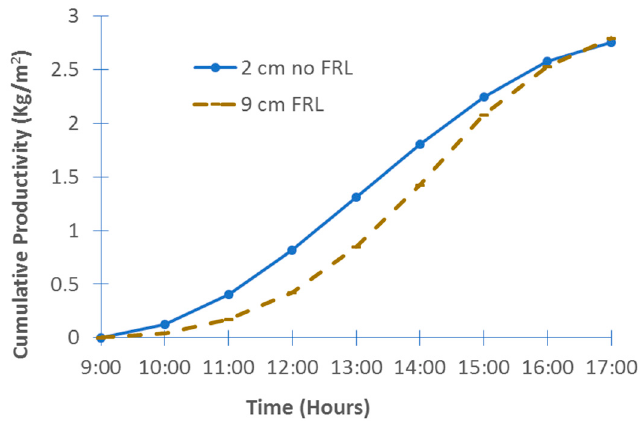
Figure 9. Hourly variation of cumulative productivity for 2 cm without FRL and 2 cm with FRL.